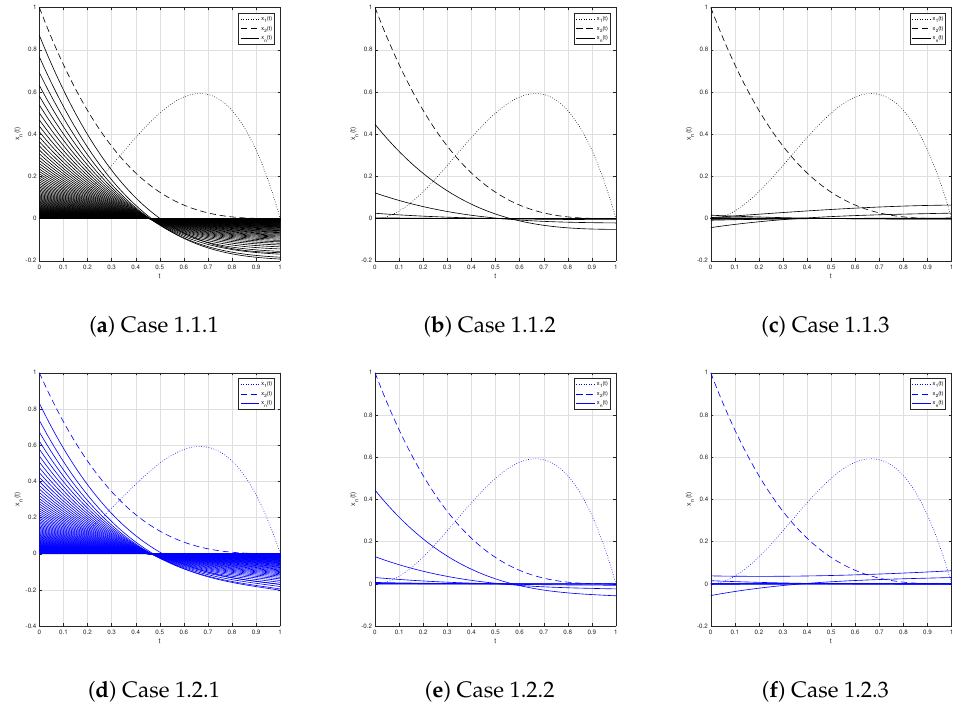
Figure 2. Convergence behavior of the sequence { x n ( t ) } with and without the extrapolation factor ( θ n ) for Case